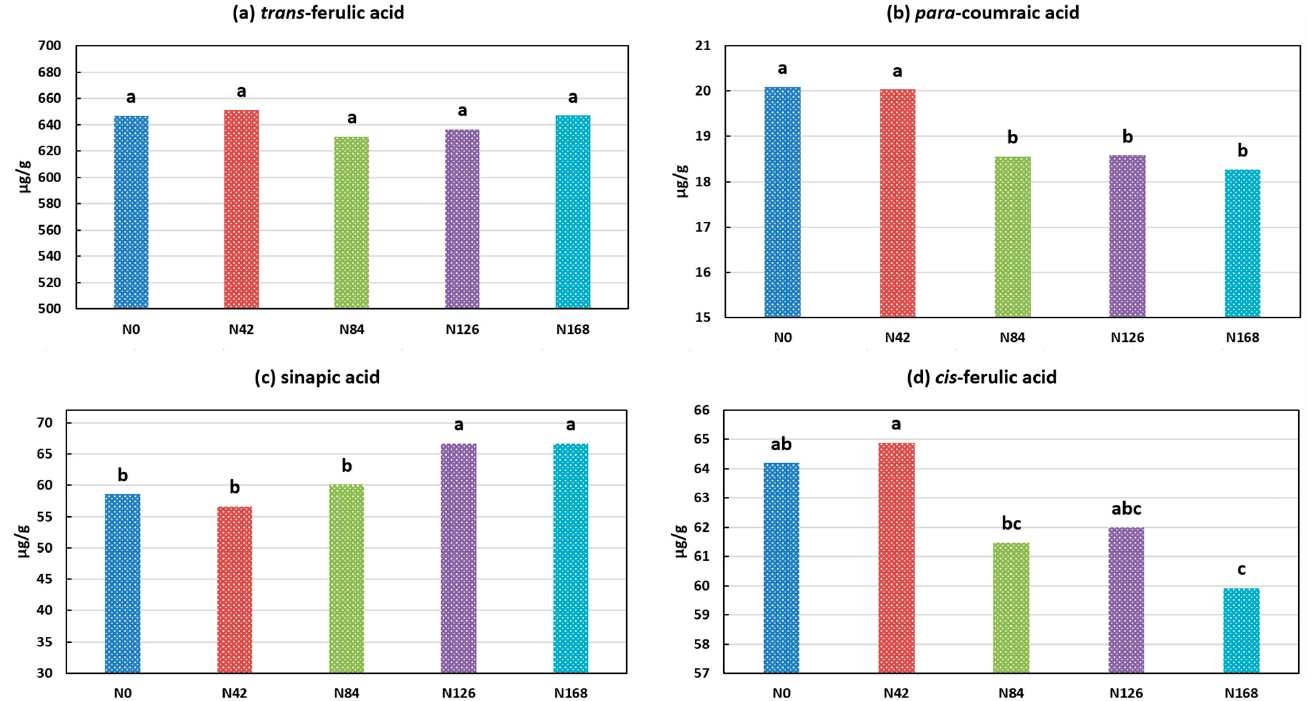
Figure 2. Effect of different nitrogen rates on phenolic acid composition ( a ) trans -ferulic acid; ( b ) para -coumaric acid; ( c ) sinapic acid; ( d ) cis -ferulic acid. Within each figure, values with different letters are considered significantly different ( p < 0.05).